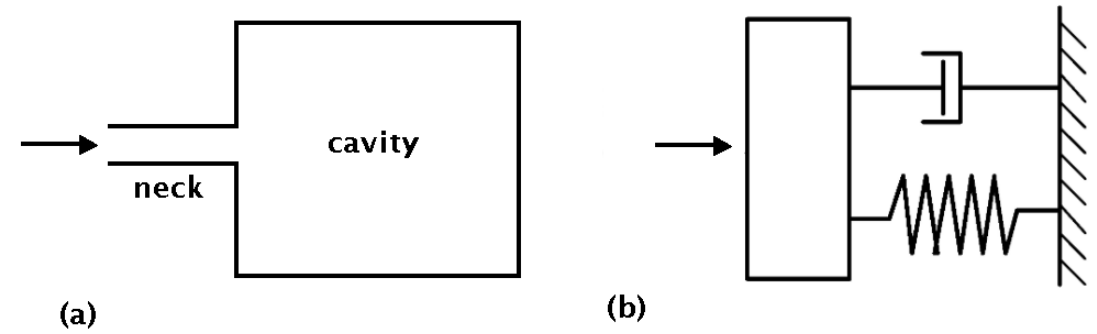
Figure 2. Scheme of the principle of operation of a simple Helmholtz resonator: ( a ) Description of Helmholtz resonator functioning and ( b ) the equivalent mass-spring model.